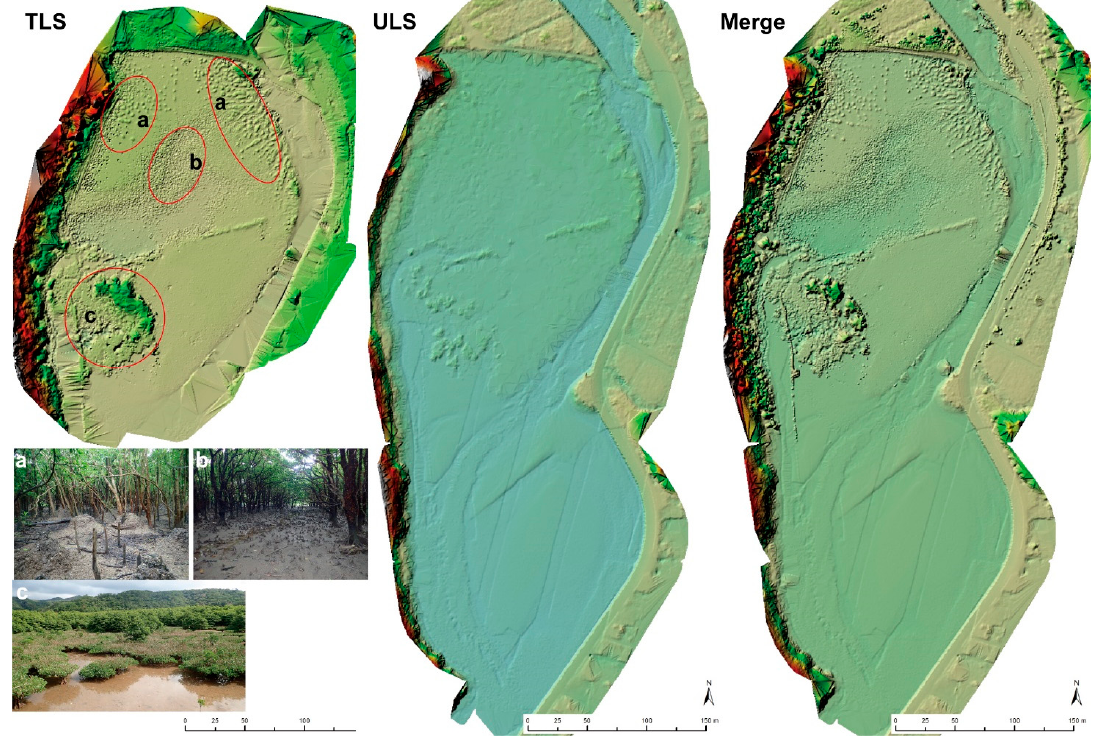
Figure 3. DTM built from 3D point cloud model. ( a ): heaps of T. anomala , ( b ): forest floor microtopography, ( c ): area where shrub K. obovata was widely dispersed and could not be traversed.